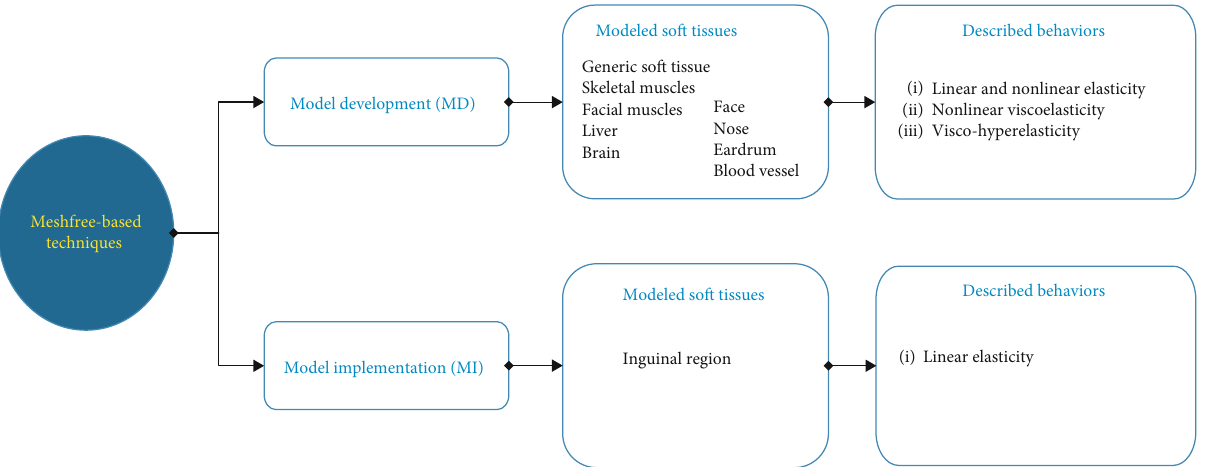
Figure 4: Overview of all modeled soft tissues and di ff erent described behaviors for meshfree-based studies.